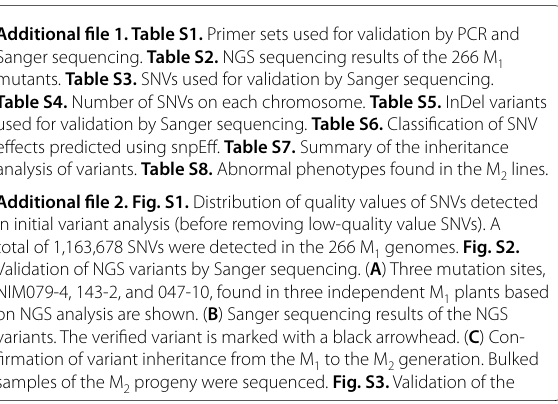
Additional file 1. Table S1. Primer sets used for validation by PCR and Sanger sequencing. Table S2. NGS sequencing results of the 266 M 1 mutants. Table S3. SNVs used for validation by Sanger sequencing. Table S4. Number of SNVs on each chromosome. Table S5. InDel variants used for validation by Sanger sequencing. Table S6. Classification of SNV effects predicted using snpEff. Table S7. Summary of the inheritance analysis of variants. Table S8. Abnormal phenotypes found in the M 2